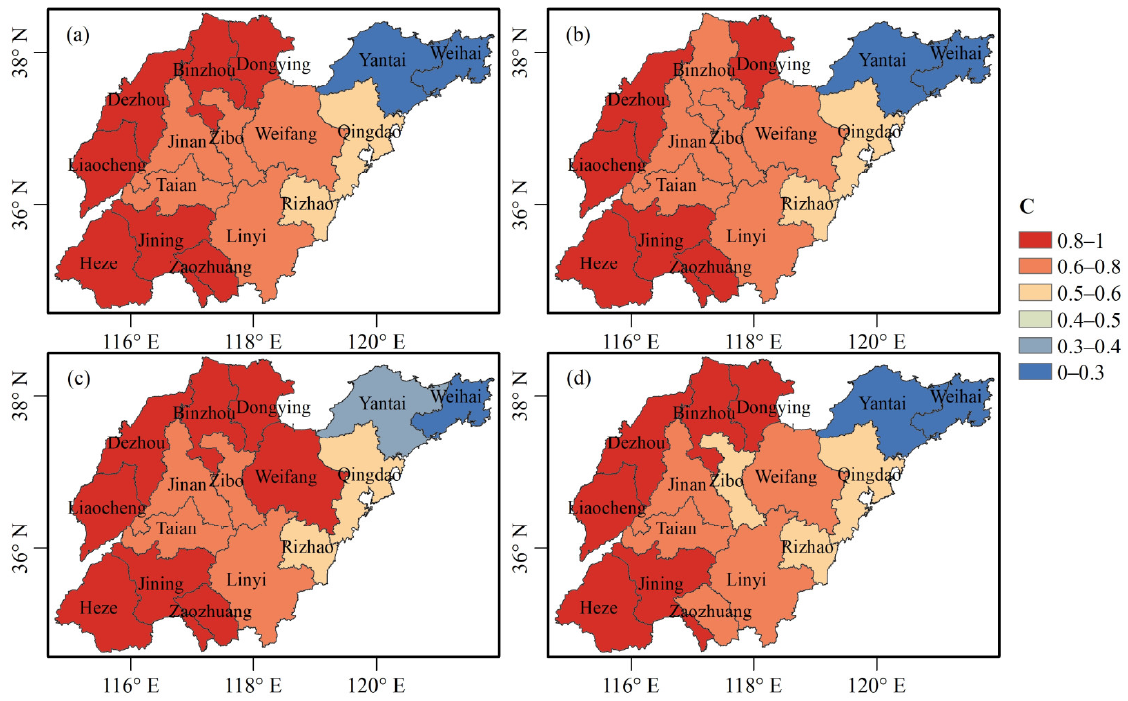
Figure 5. Distribution of coupling coordination degree of Annual average AOD and AQI in prefecture level cities in Shandong Province in ( a ) 2015~2020, ( b ) 2015, ( c ) 2019 and ( d ) 2020.